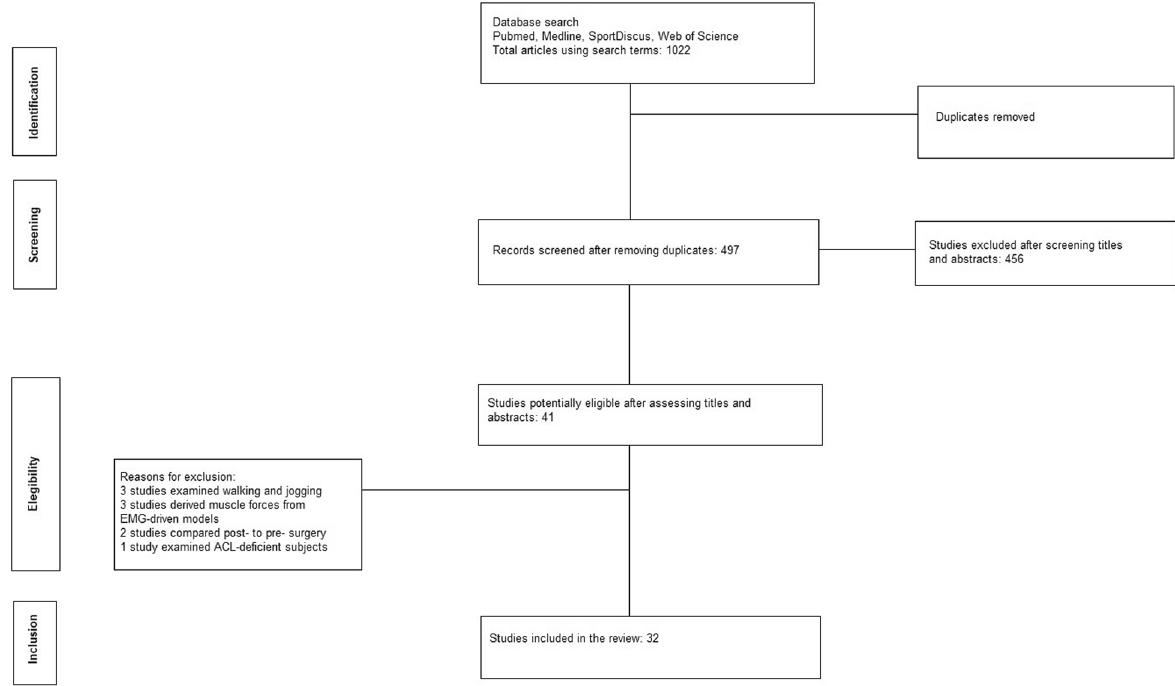
Fig. 1 Flow chart of the search and included and excluded